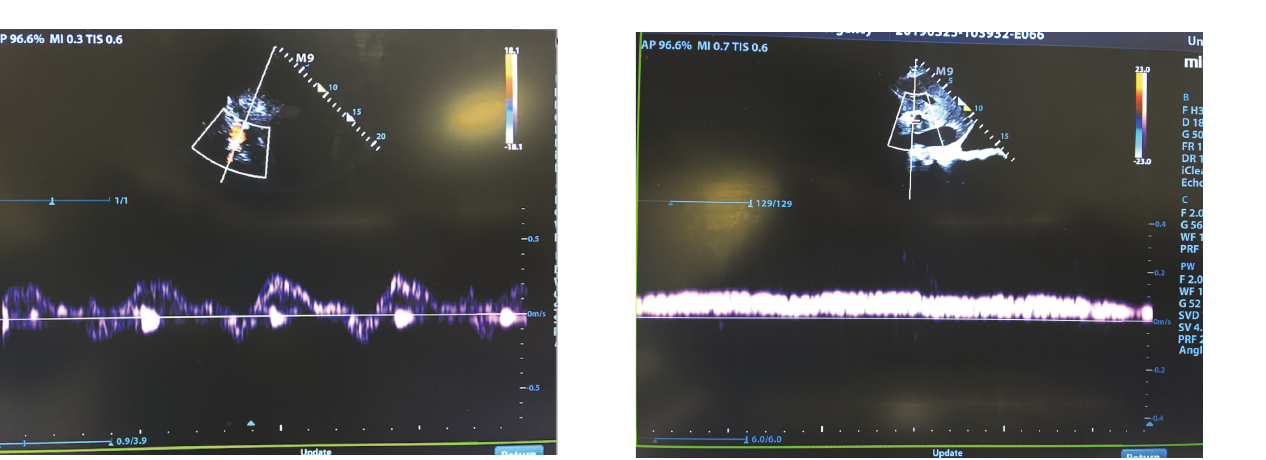
Figure 5: Portal vein Doppler exam on day 3. The pulse was 90 bpm. The pulsatility fraction was less than